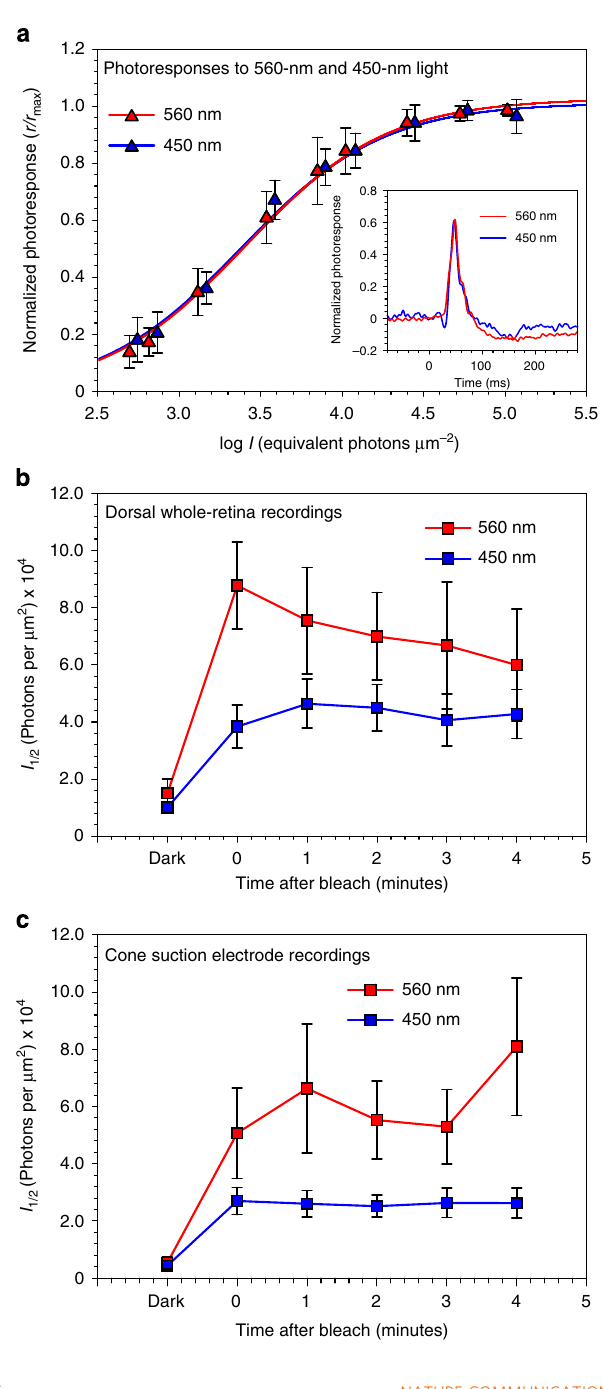
Fig. 5 Photosensitivity in Gnat1 − / − cones after exposure to 450-nm or 560-nm light. Photoresponses were recorded from M (508-nm) cones in Gnat1 − / − retinas before and after 15-second exposures to 450-nm or 560-nm light calculated to bleach 85% of the M-cone pigment. a Mean suction-electrode responses ( ± s.e.m.) from dark-adapted M cones as a function of fl ash intensity to 450-nm ( n = 7) and 560-nm ( n = 10) light at the same LED current and fl ash durations. Peak response amplitudes ( r ) were separately normalized to maximum peak response amplitudes at saturating light intensities ( r max ) for the two wavelengths, and intensities were multiplied by 0.6 to give equivalent intensities at the λ max of the M-cone pigment. Curves are Michaelis-Menten equation with values of I 1/2 of 2410 for 450 nm and 2560 for 560 nm (in equivalent photons μ m − 2 ). Inset: mean responses to 450-nm and 560-nm light of fl ashes 2.5 ms in duration at intensities of approximately 3600 equivalent photons μ m − 2 . b , c Mean M-cone responses ( ± s.e.m.) before and after bleaching 85% of the cone visual pigment from b whole dorsal Gnat1 − / − retinas from fi ve mice and c suction-electrode recordings from single Gnat1 − / − cones ( n = 14 for 450-nm bleach, n = 12 for 560-nm bleach). Bleaching was performed with the same 450-nm and 560-nm light sources used in a . Cones and whole retinas were stimulated before and after the photobleach with three 500-nm fl ash intensities spanning the range of cone responses from small to nearly saturating. Mean response amplitudes were used to estimate the intensity required to produce a half-maximal response from fi ts to the Michaelis – Menten